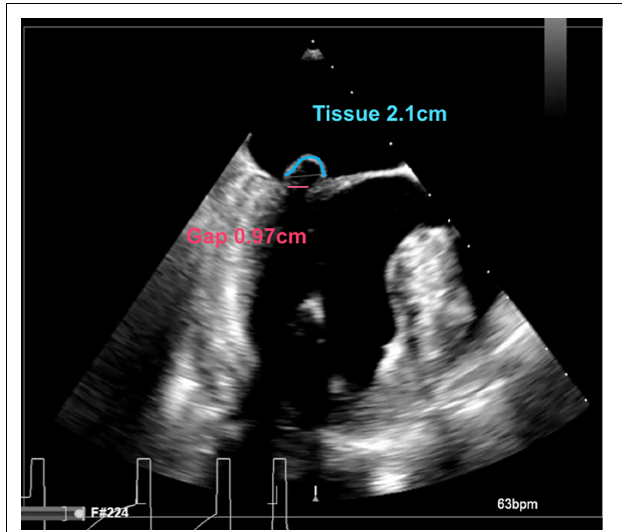
FIGURE 2 | Intraoperative long-axis TEE view showing part of the left atrium, the left ventricle and the left ventricular outflow tract, before repair with the HARPOON device. The measurement of the tissue/gap-ratio is demonstrated. Tissue-length (red), 2.1 cm; gap-length (blue), 0.97 cm. Tissue/gap-ratio = 2.1/0.97 =